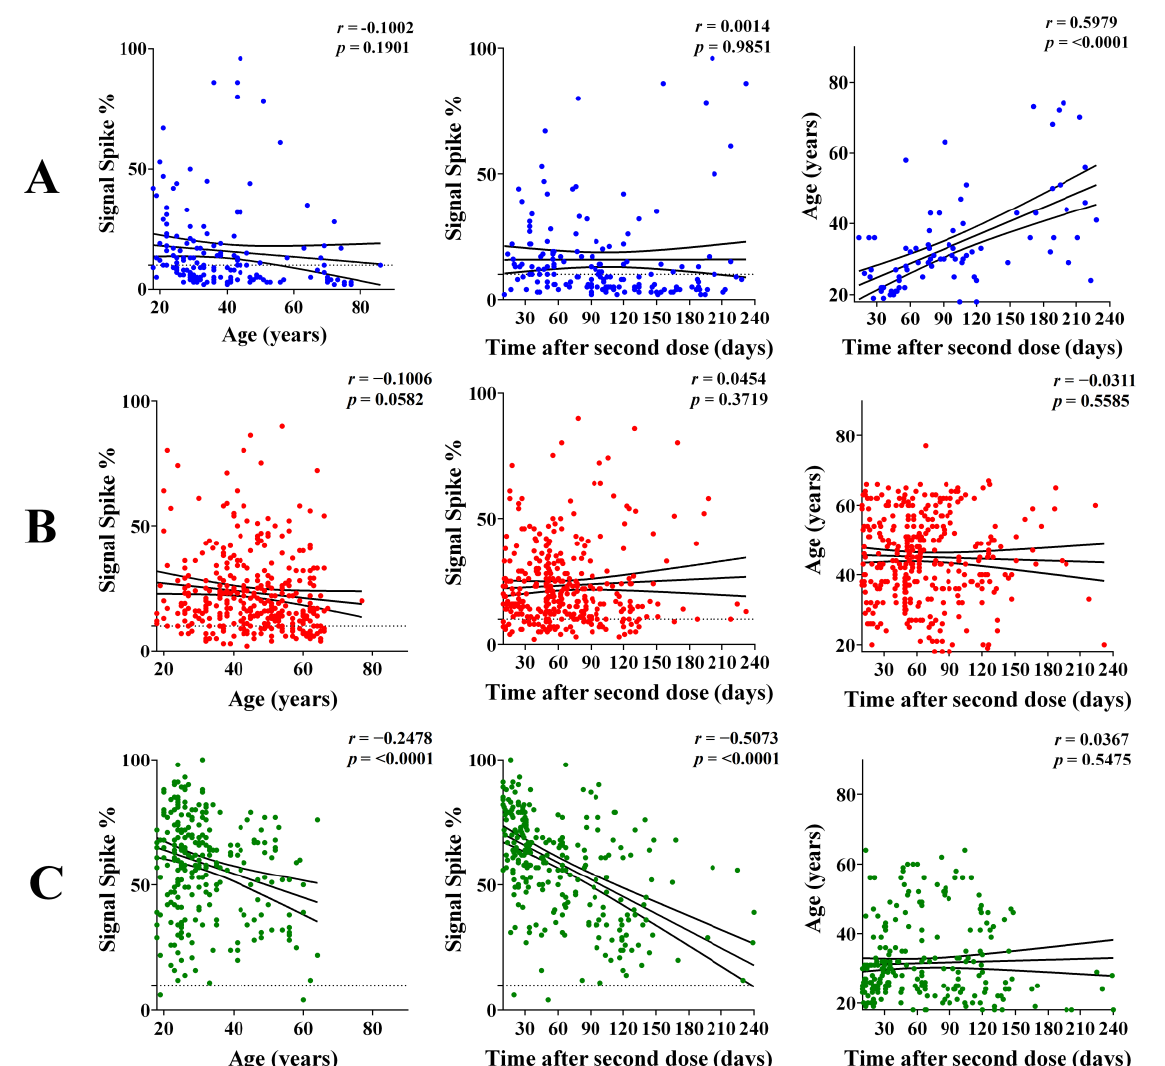
Figure 2. Correlation between the levels of IgG reactive to spike and the age or time after the second vaccine dose. The IgG levels were determined in participants negative for COVID-19 who completed primary vaccination (2nd dose) between 10 and 240 days. ( A ) Correlations between IgG levels and age. ( B ) Correlations between IgG levels and time after the second dose. ( C ) Correlations between age and time after the second dose. The linear regression with 95% CI and Pearson’s correlation coefficient is indicated. Color code, green BNT162b2, red ChAdOx1-S, blue CoronaVac.